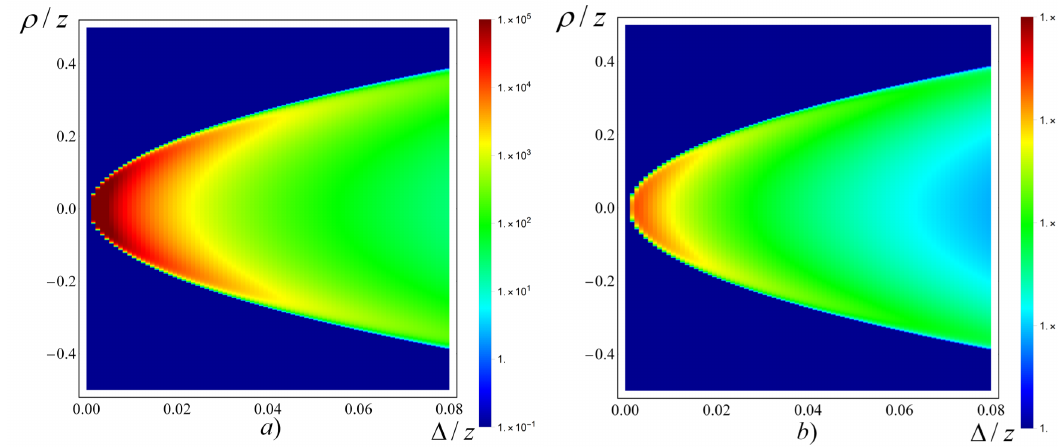
Figure 10. Light field distribution in a pulsed beam on the plane ( ∆ / z , ρ / z ) for direction θ = 0 ( a ) and upon integrating over angles ( b ). The calculations were carried out for σ tr z = 0.5, σ tr / σ a = 0.25 and the phase function of sea water ( ⟨ cos γ ⟩ =